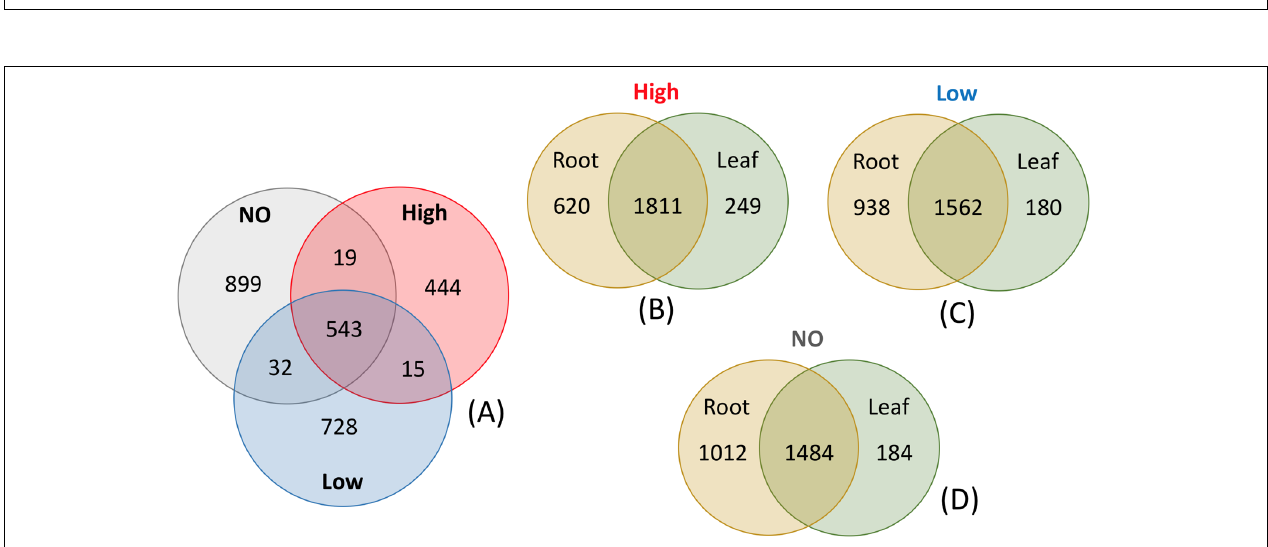
FIGURE 7 | Venn diagrams of root endophytic communities exposed to a mixed pollution gradient (A) , and endophytic communities of J. acutus exposed to high (B) , low (C) pollution as well as no pollution (D) .